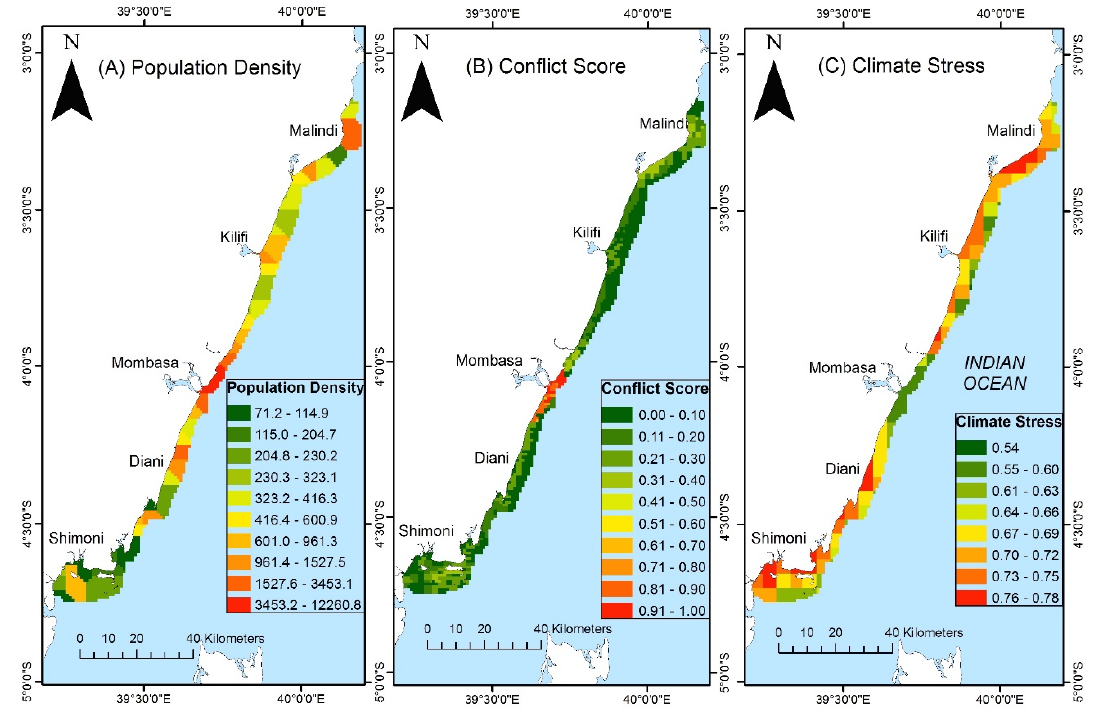
Figure 4. Map of ( A ) estimated relative population density pressure on marine pixels based on the population of the nearest land pixel; ( B ) calculated estimates of potential for resource use conflicts; and ( C ) coral reef climate exposure index based on the multivariate stress model.